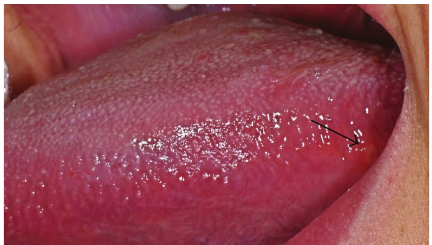
Figure 3: Unilateral aphthous ulcer at lingual margin in a potential coeliac patient (B Group).